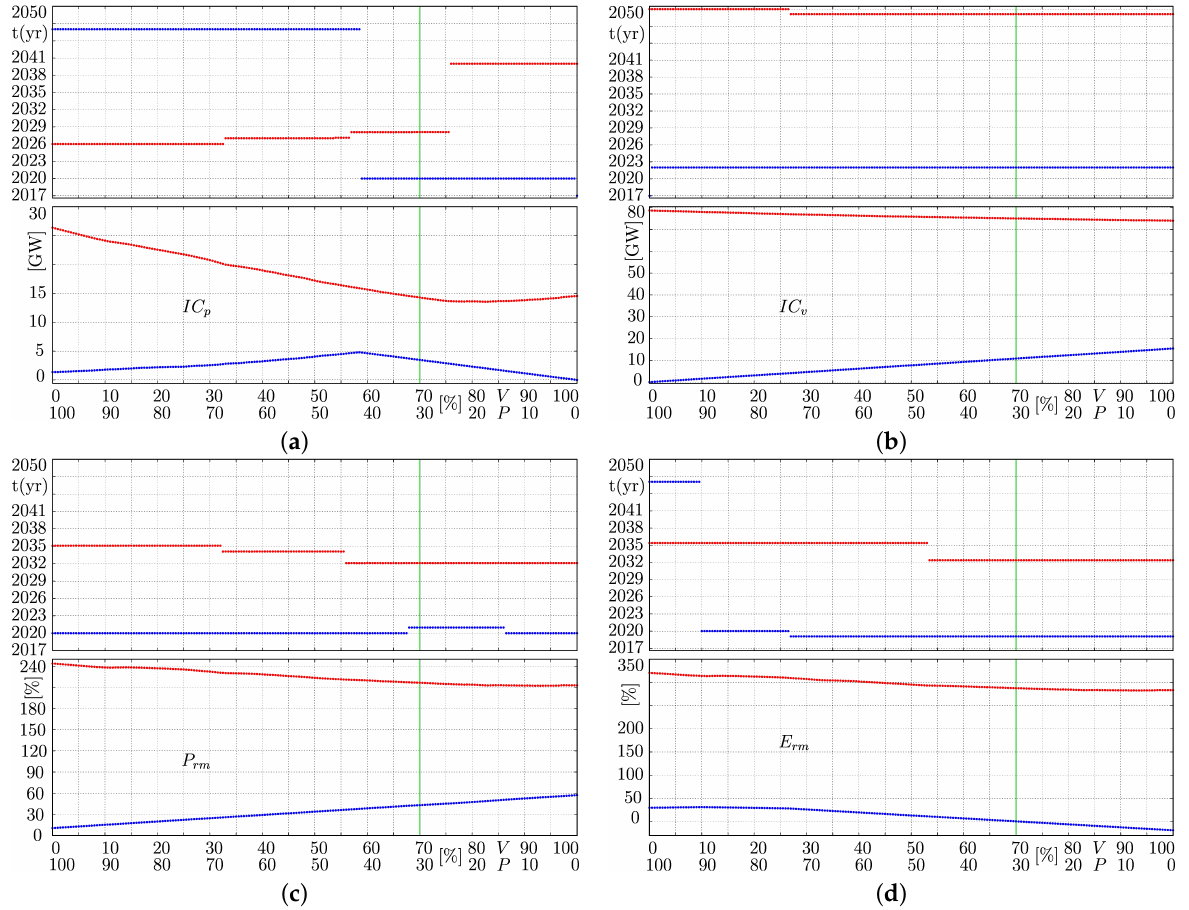
Figure 12. Confidence limits of the V / P scenarios and their times of occurrence. The red and blue lines represent maximum and minimum values, respectively. The green vertical line represents the Colombian case (70%V, 30%P). ( a ) IC p , ( b ) IC v , ( c ) P rm , and ( d ) E rm